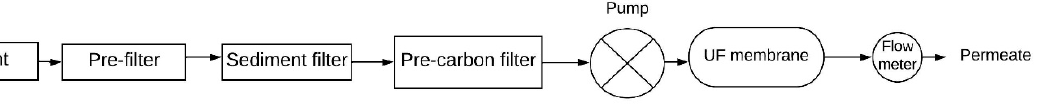
Figure 1. Flowchart of experiment set up (Combination 1: pre-filtration and UF membrane installed in series).